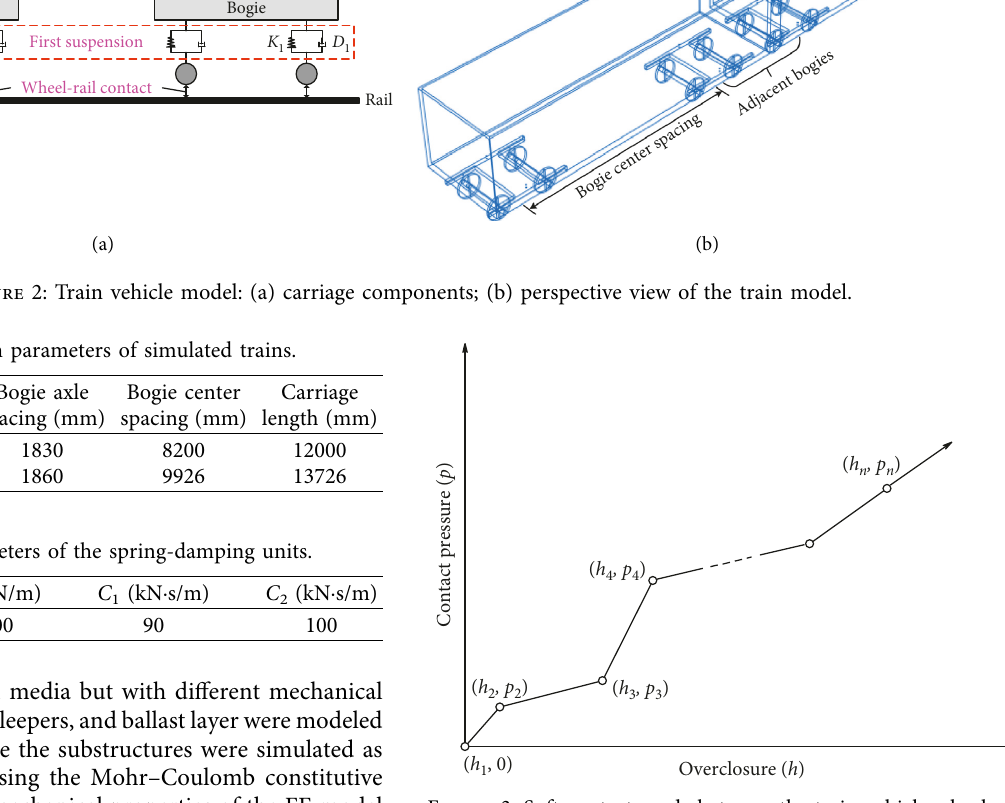
Figure 3: Soft contact mode between the train vehicle wheel and rail in the vertical